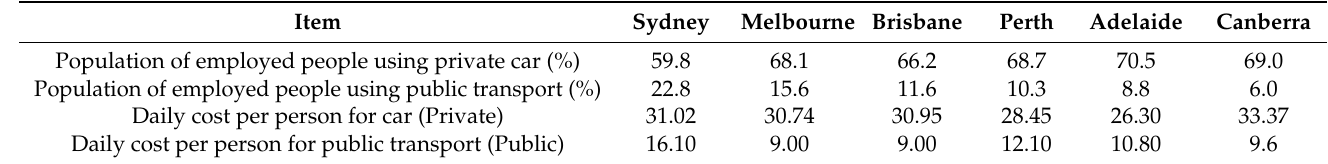
Table A6. Transportation costs for each WFH